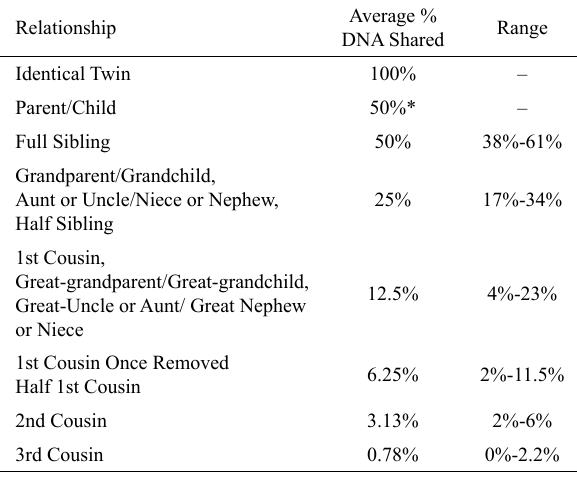
Table 3 – Average percentage and expected range of DNA shared between family members (modified from a 23andMe table available at https:// customercare.23andme.com/hc/en-us/articles/212170668-Average-Percent-